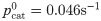
Congression probability plotted against catastrophe rate.Overexpressing catastrophe inducing factors can severely limit the congression probability. Each point represents the fraction of n = 10 independent runs of the simulations that have reached congression during a waiting time of 103s. Congression is stable over a wide range of catastrophe rates, but breaks down completely at approximately at pcat0=0.046s−1.